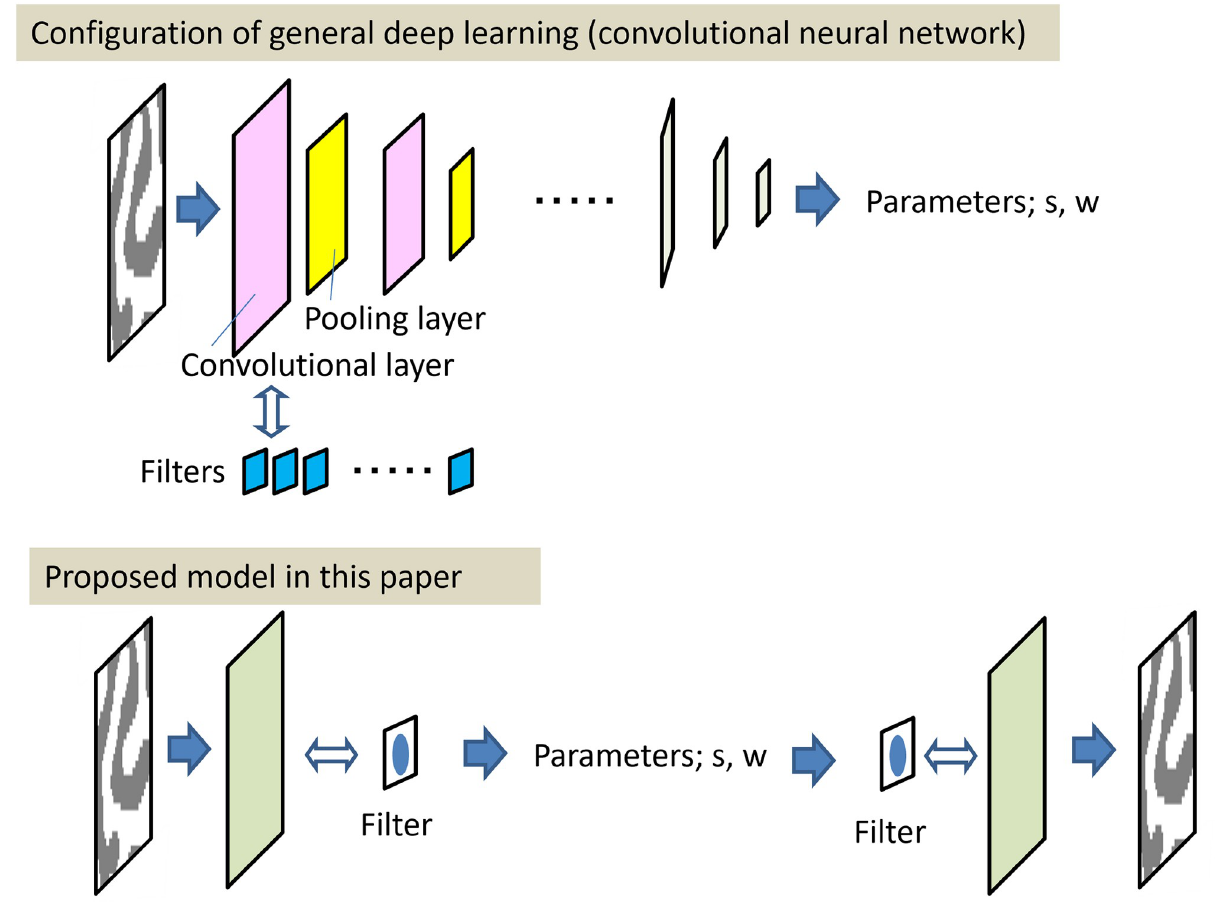
Fig 17. Comparison between the general convolutional neural network and the proposed